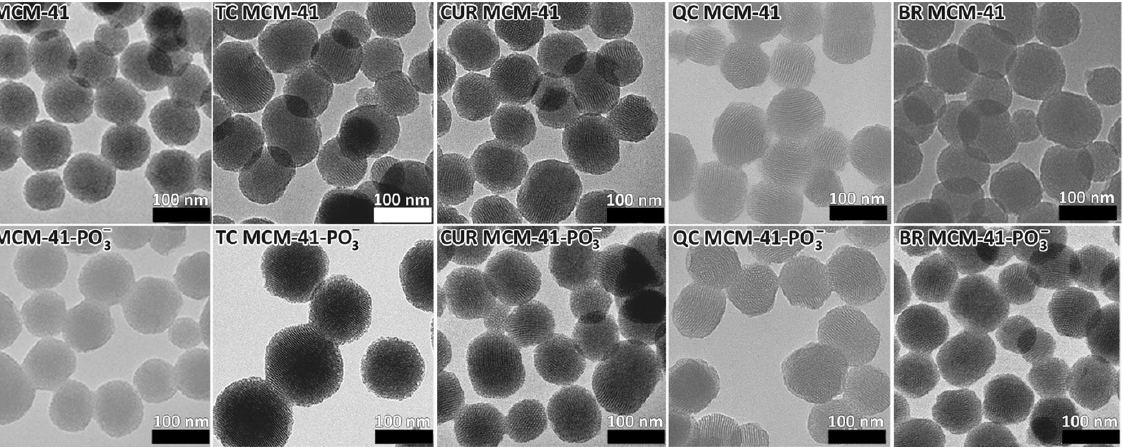
Figure 2. Transmission electron microscopy (TEM) for SrtAIs MCM-41 and MCM-41-PO 3 − . Scale bars represent 100 nm.